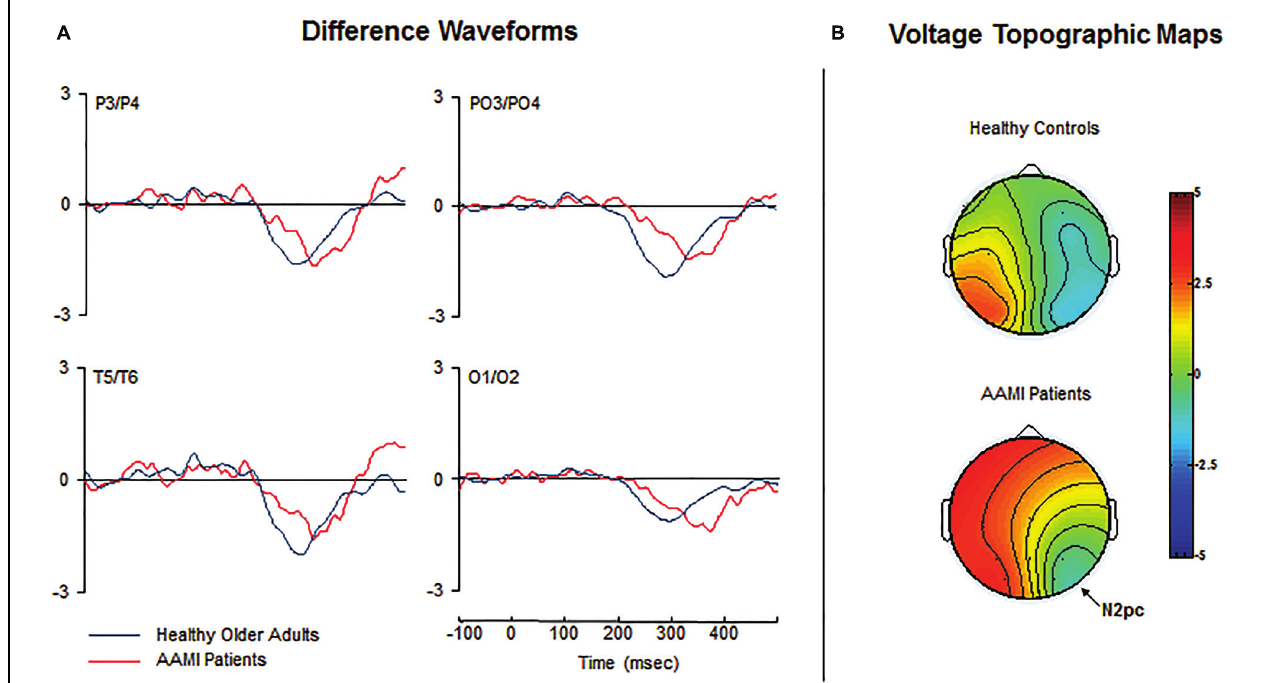
FIGURE 3 | (A) Grand-average contralateral-minus-ipsilateral difference waveforms for healthy older adults (blue lines) and AAMI patients (red lines). (B) Voltage topographic maps showing the N2pc amplitude distribution in healthy older adults and AAMI patients at the latency of the peak amplitude. The N2pc topographical scalp distribution was maximal at occipital sites in both